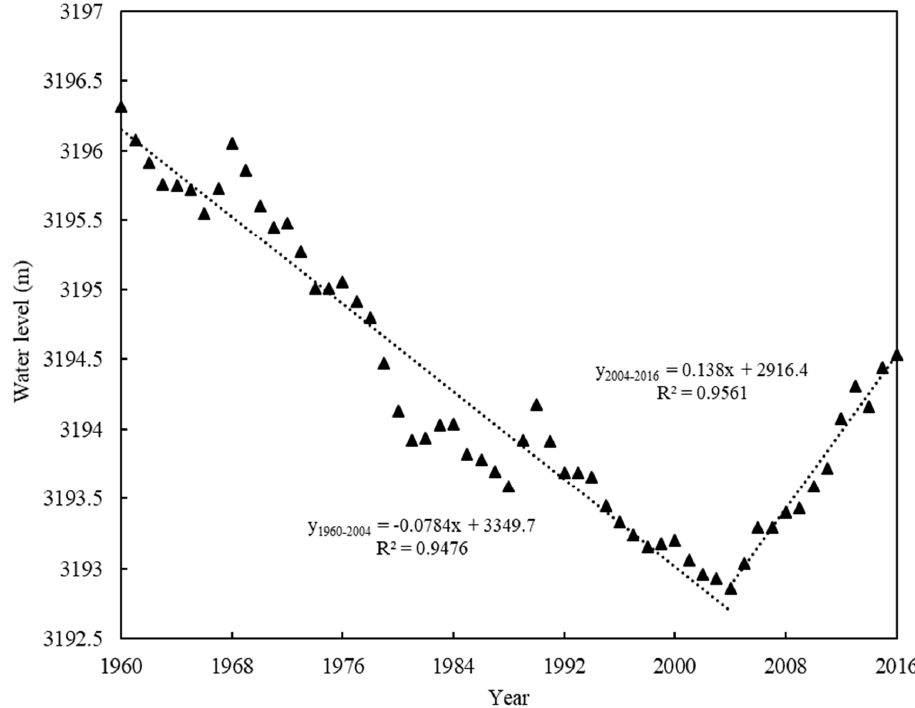
Figure 2. The annual water levels of Qinghai Lake recorded during the period 1960–2016.